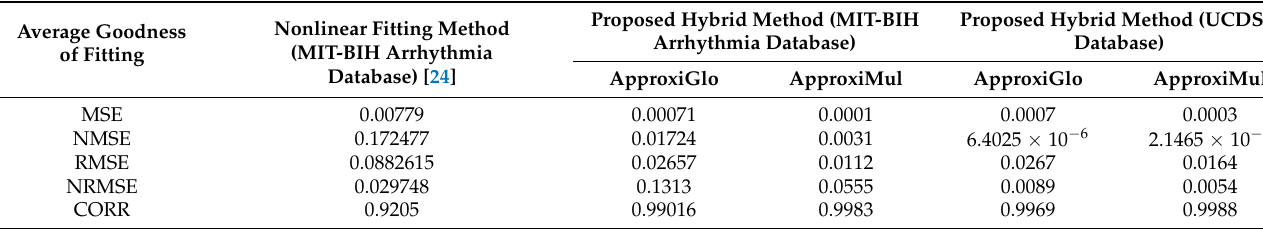
Table 1. Comparison between the proposed ApproxiGlo and ApproxiMul and the nonlinear fitting method described in [24] for normal ECGs.